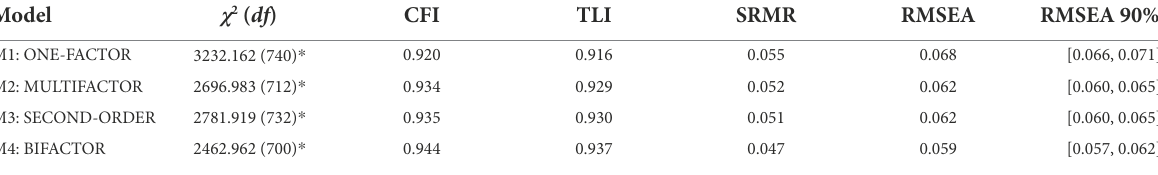
TABLE 4 Fit indices for alternative measurement models for the Antisocial Beliefs Scale. Model